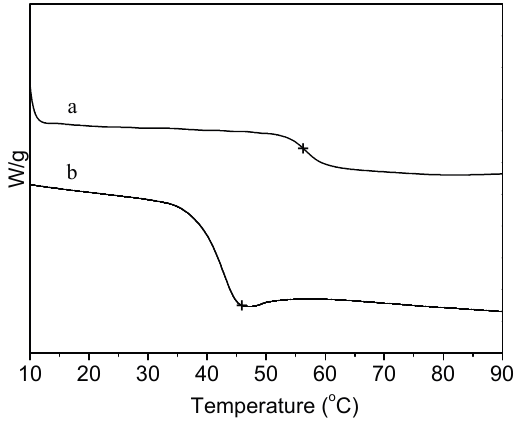
Figure 4. DSC curves of (a) PLA and (b)